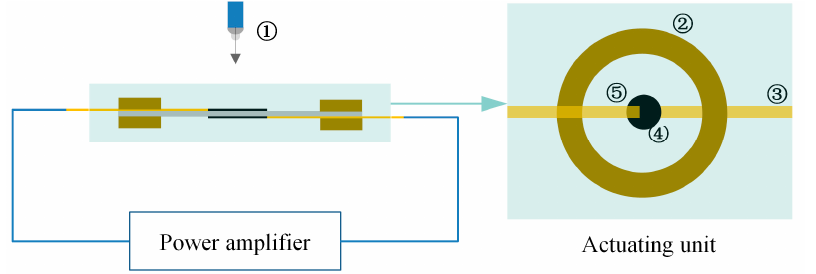
Figure 4. Schematic diagram of electrostrain experimental platform. (1) High-speed camera, (2) Fixed frame, (3) Copper foil, (4) Flexible electrode, (5) Polyurethane composite fiber